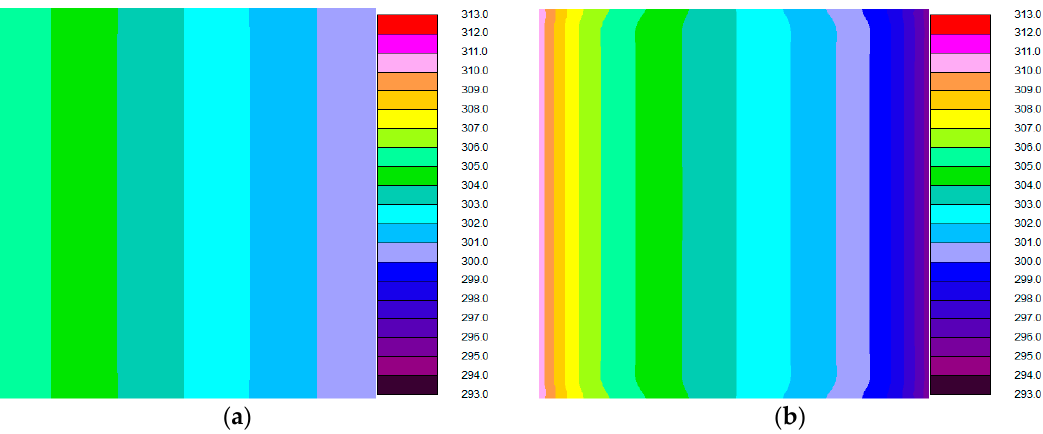
Figure 9. The plate temperature distributions of counter-flow plate heat exchanger ( a ) Heat transfer